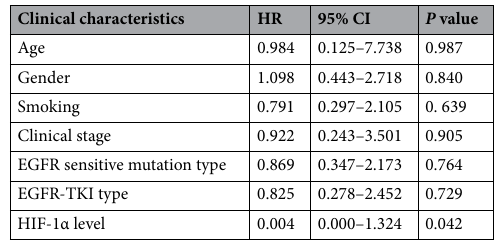
Table 8. Cox regression analysis of clinical characteristics as influencing factors of EGFR-TKIs acquired resistance occurring for 20 cases with acquired EGFR T790M mutation. HR hazard ratio, CI confidence